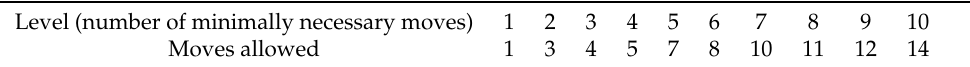
Table 1. Difficulty adjustment by setting maxima on the number of moves allowed in the Tower of London Test. Exceeding the number of allowed moves for an item resulted in a score of 0 for that item regardless of whether the participant eventually reached the required configuration or not. As a result of this adjustment, the probability of correct response to the easiest item was 0.991, whereas that to the most difficult one was